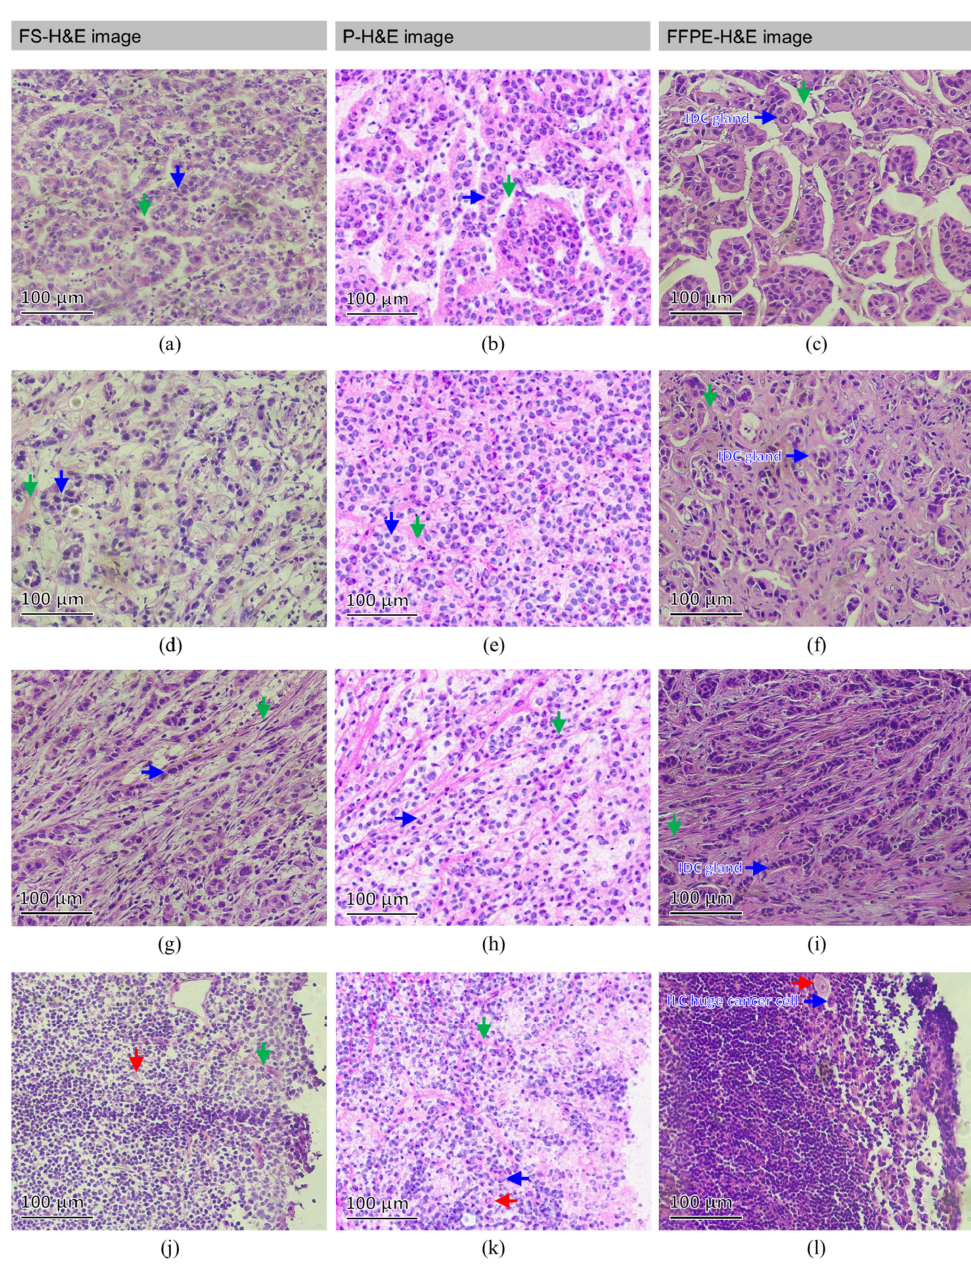
Figure 7. Featured FS-H&E, p-H&E, and FFPE-H&E images of the equivalent positions acquired from the same BC-metastatic SLNs of individual patients. Blue arrows in ( a – c ) indicate the invasive glandular cells from the same IDC-metastatic SLN #A of patient #24, while green arrows indicate the cleft spaces enhanced by frozen fracture and FFPE dehydration. The blue arrows of ( d – f ) indicate the invasive glandular regions (transversal section) from the same IDC-metastatic SLN #A of patient #23, while green arrows indicate stromal fibrosis. Blue arrows in ( g – i ) represent the invasive ductal carcinoma with Indian file pattern (longitudinal section) from the same IDC-metastatic SLN #A2 of patient #28, while green arrows indicate the stromal fibrosis as well. In ( j – l ), all the right regions from the same ILC metastatic SLN #A of patient #11 indicate atypical morphology: (1) green arrows indicate the stromal collagen fibers; (2) red arrows indicate the benign stromal macrophages; (3) blue arrows indicate the metastatic ILC pleomorphic enlarged atypical cancer cells. In ( j ), no atypical cancer cells were